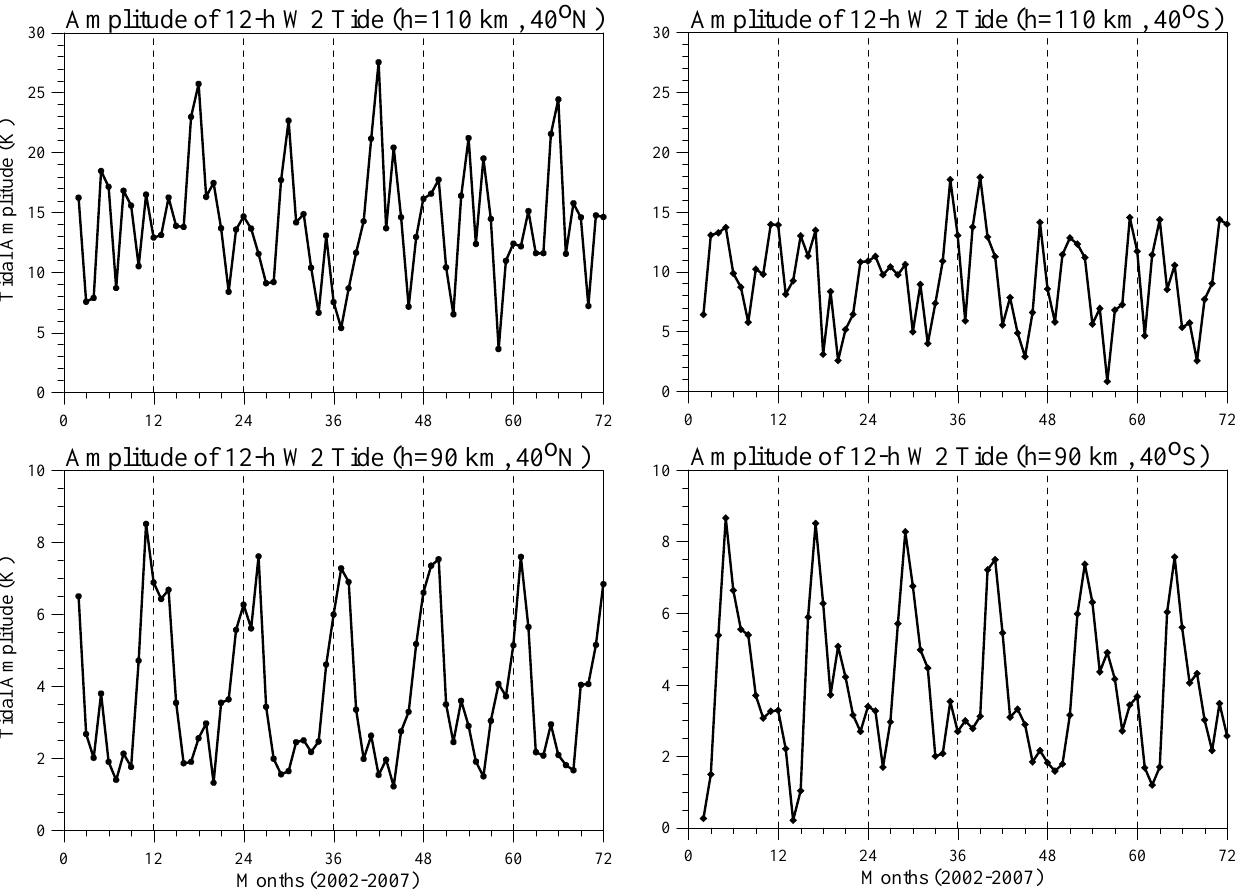
Figure 3 Fig. 3. Temporal distribution of the monthly mean tidal amplitudes at heights: 110km (upper row of plots) and 90km (bottom row of plots) for 40 ◦ N (left column of plots) and 40 ◦ S (right